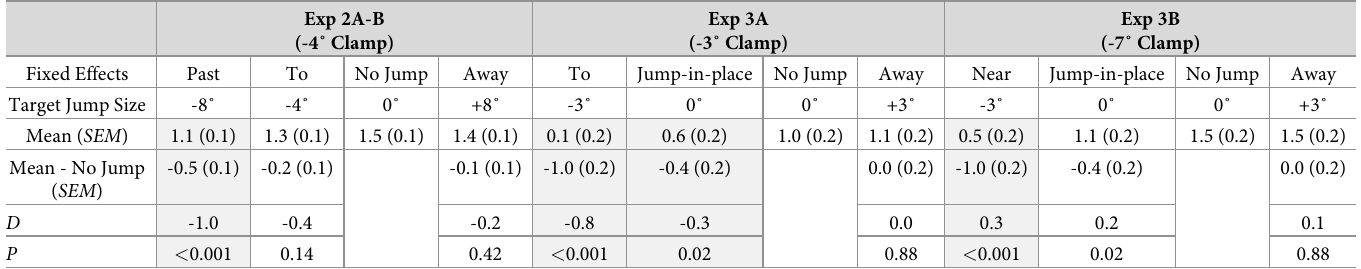
Table 2. Summary of model-free